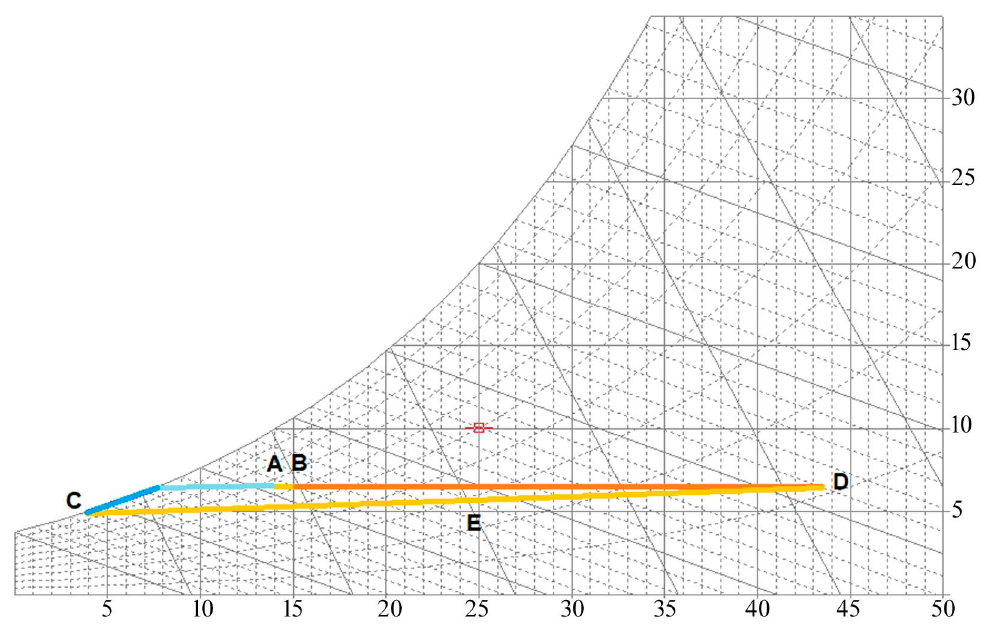
Figure 9. Transformation on the Ashrae Diagram (15 August).